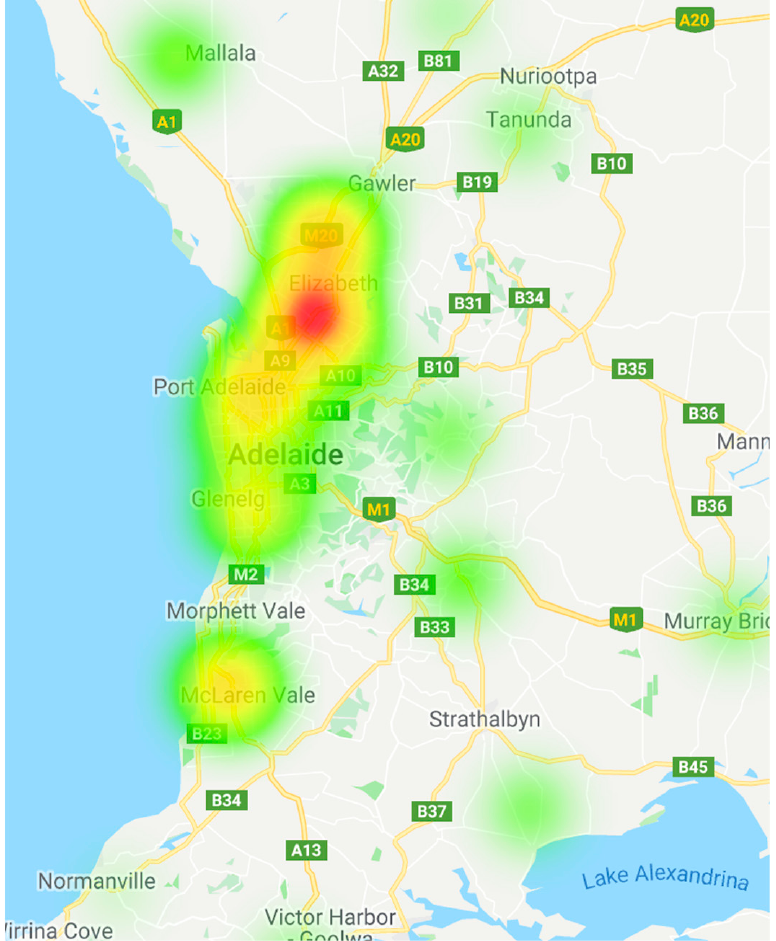
Figure 5. Heat map of the prevalence of animal welfare offences in South Australia’s metropolitan areas.